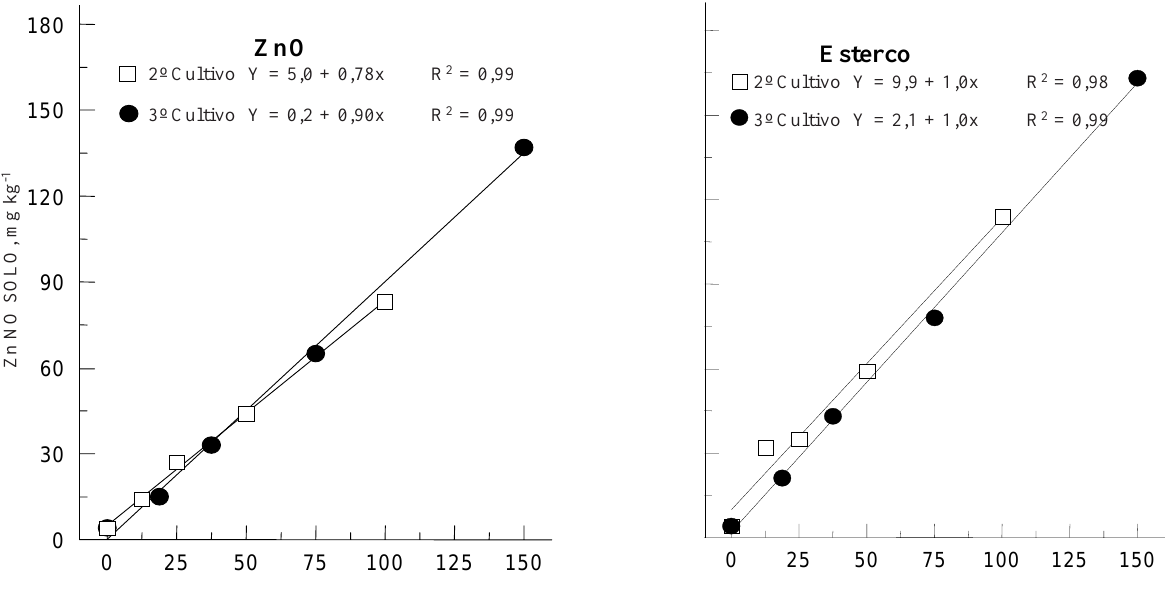
Figura 1. Teores de zinco no solo extraído com solução de HCl 0,1 mol L -1 nas amostras coletadas após o segundo e o terceiro cultivo de milho, considerando a aplicação de quantidades crescentes e cumulativas de Zn na forma de esterco de suínos ou de ZnO. Média de três repetições.